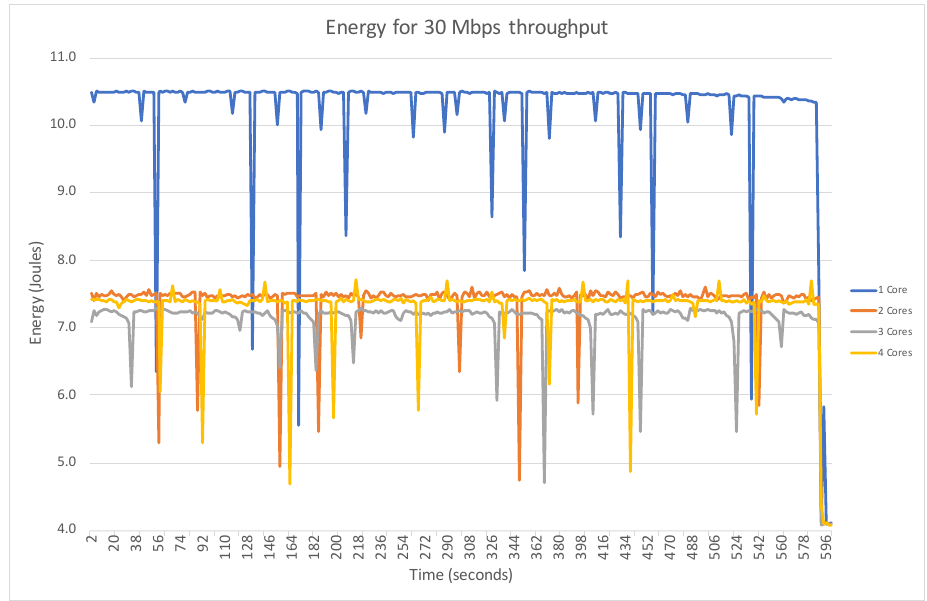
Figure 8. Energy consumed during the last second that proceeds the measurement for different number of cores during a 30 Mbps traffic.